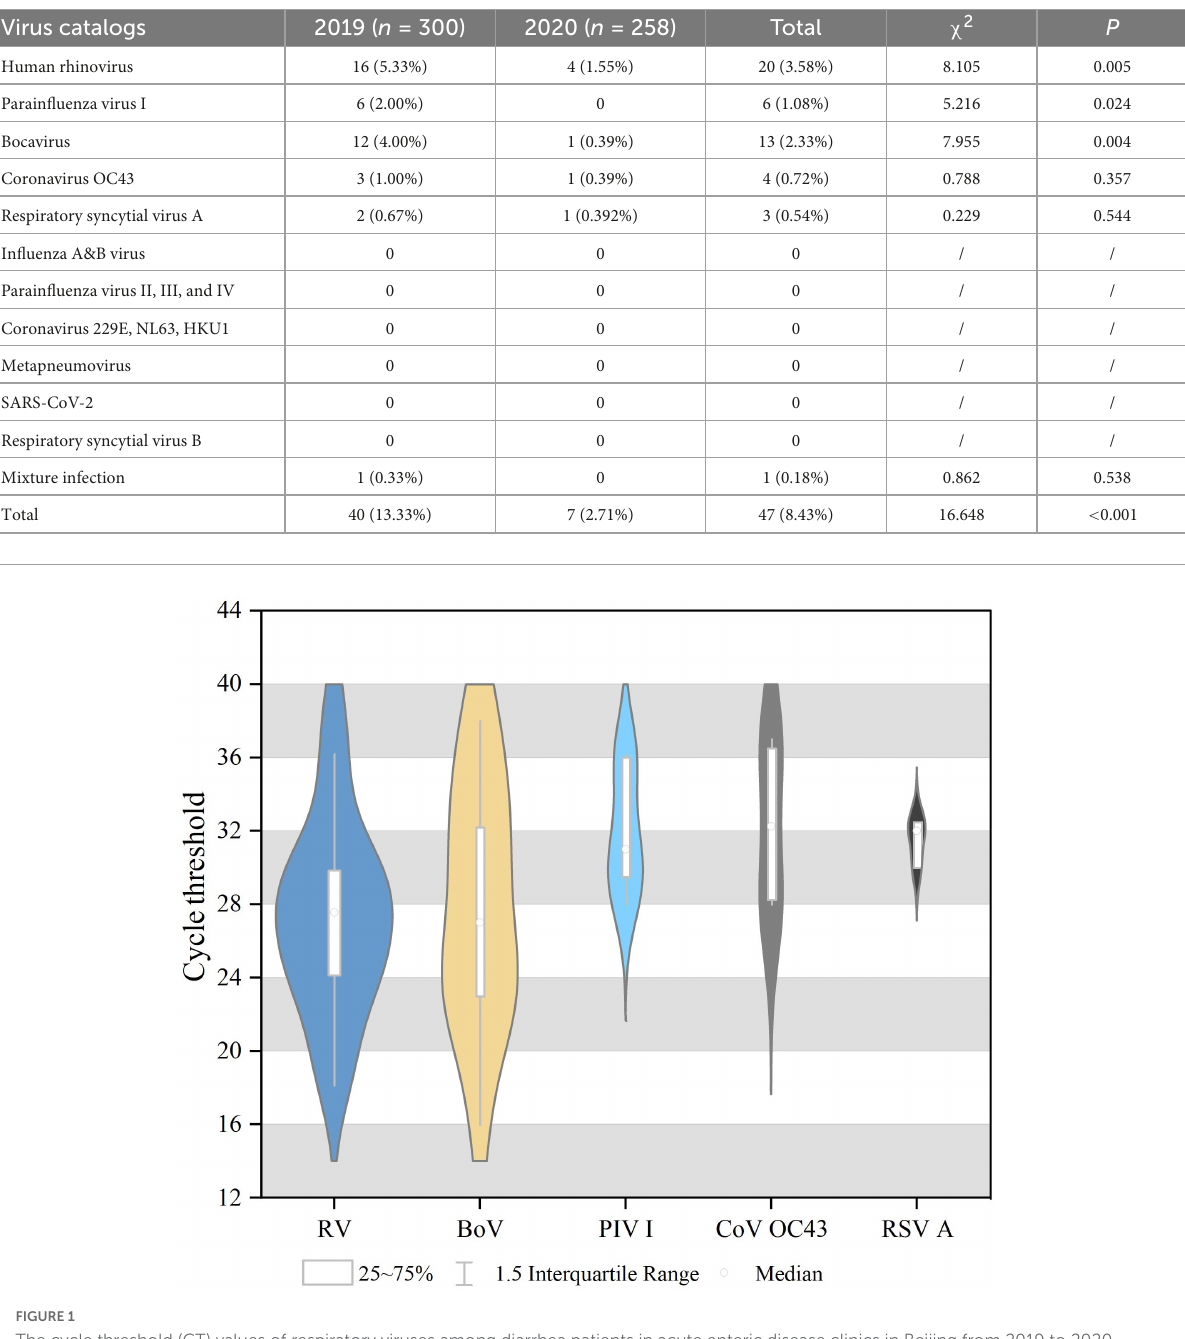
TABLE 1 The detection of respiratory viruses among diarrhea cases in enteric disease clinics in Beijing from 2019 to 2020. Virus catalogs